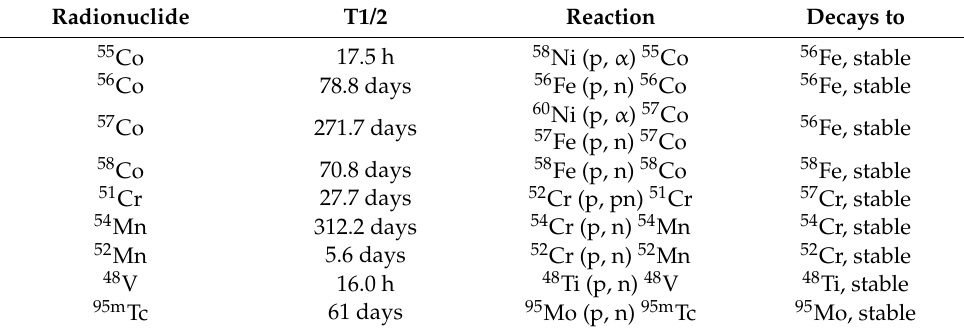
Table 1. Possible impurities deriving from irradiation with protons of Havar foil. Radionuclide T1/2 Reaction Decays